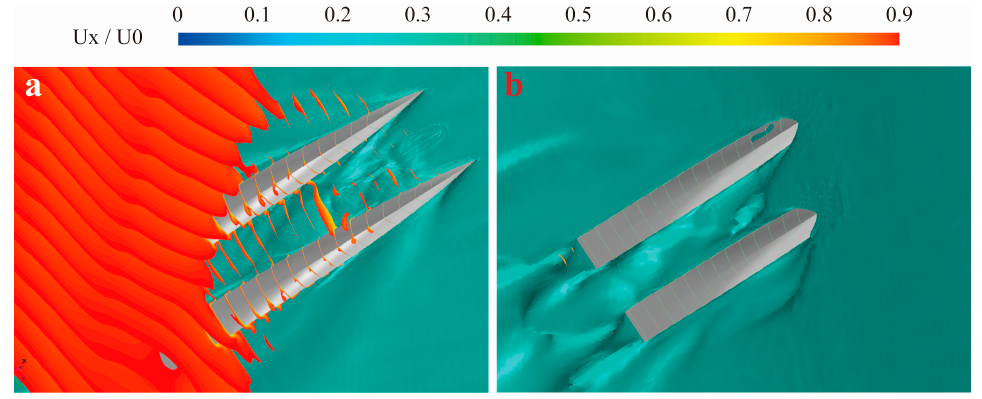
Figure 32. Boundary layer represented by slices colored with dimensionless axial velocity limited to Ux/U0 = 0.9 at 7 level sea state with the 30° wave direction. ( a ) T = 1/4 T 0; ( b ) T = 2/4 T 0; ( c ) T = 3/4 T 0; ( d ) T = 4/4 T 0. 5. Conclusions In this paper, the interaction between the wave and a catamaran USV is studied based on the CFD method. The simulation results are concluded as follows: (1) The amplitude of the heave motion in the 0° and 30° wave directions is basically the same under the 7 level sea state, and it changes periodically in the range of − 5 m to 5 m. The pitch angle ranged from − 12 to 12 degrees at the 0° wave direction and from − 12 to 10 degrees at the 30° wave direction. The positive value for bow raising and the negative value for bow diving. The stable roll angle of the USV is very small in the 0° wave direction. The roll angle of the USV is obvious in the 30° wave direction, which ranged from − 7 to 6 degrees. The total resistance in the 0° wave direction is slightly greater than that in the 30° wave direction. The six degrees of freedom (6DOF) motion of the USV under 5 level sea state is similar to that of 7 level sea state, but the 6DOF motion amplitude of the 5 level sea state is smaller than that of 7 level sea state. (2) Taking the 7 level sea state as an example, the attitude of the USV in waves at different times is analyzed. The results show that the USV moves with six degrees of freedom following the wave cycle, and in the whole process of USV movement around the waves, the stability of the USV meets the stability requirements, and no capsizing occurs. From the pressure distribution analysis of the USV, the positive pressure at the bottom of the USV is mainly concentrated in the two side body areas, and the negative pressure is mainly concentrated in the area between the side bodies. (3) The thickness of the boundary layer in the 0° and 3° wave directions of 5 level and 7 level sea states is analyzed, respectively. The results show that the wave direction has a great influence on the boundary layer thickness. At the 0° wave direction, the distribution of the boundary layer is thicker when the USV is at the wave trough position. At the 30° wave direction, the distribution of the boundary layer is thicker when the USV is at the wave peak position. 5 level and 7 level sea states have the same conclusion.